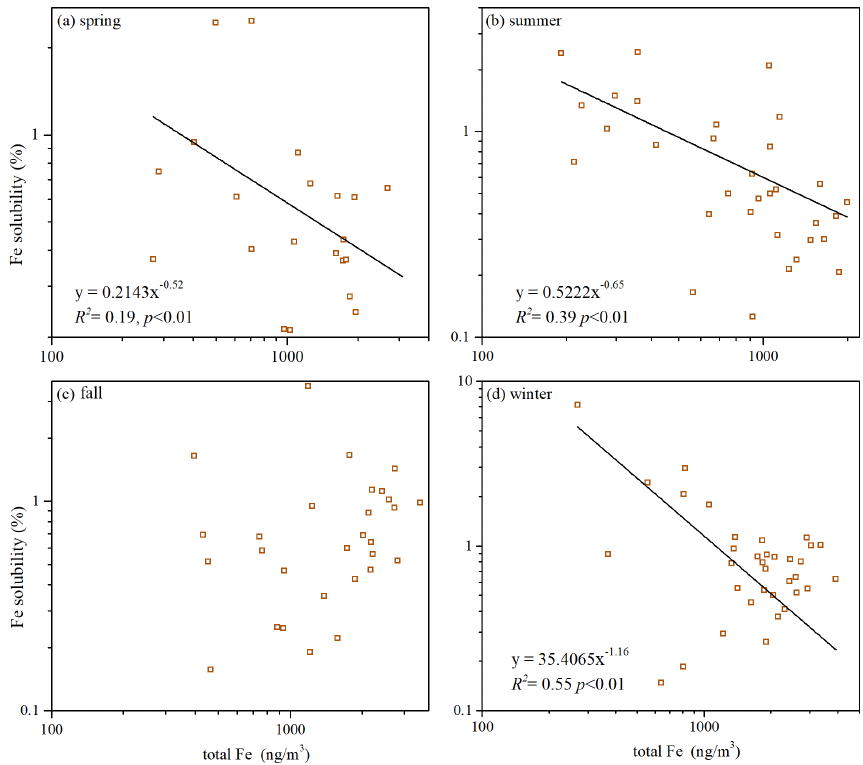
Figure 5. Fe solubility versus total Fe for coarse particles in different seasons: (a) spring; (b) summer; (c) fall; (d)